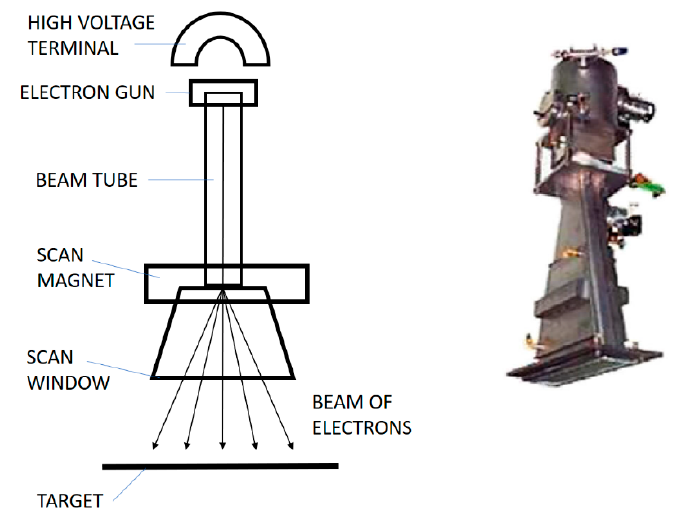
Figure 1. Modern EB apparatus: schematics ( left ) and view ( right ).